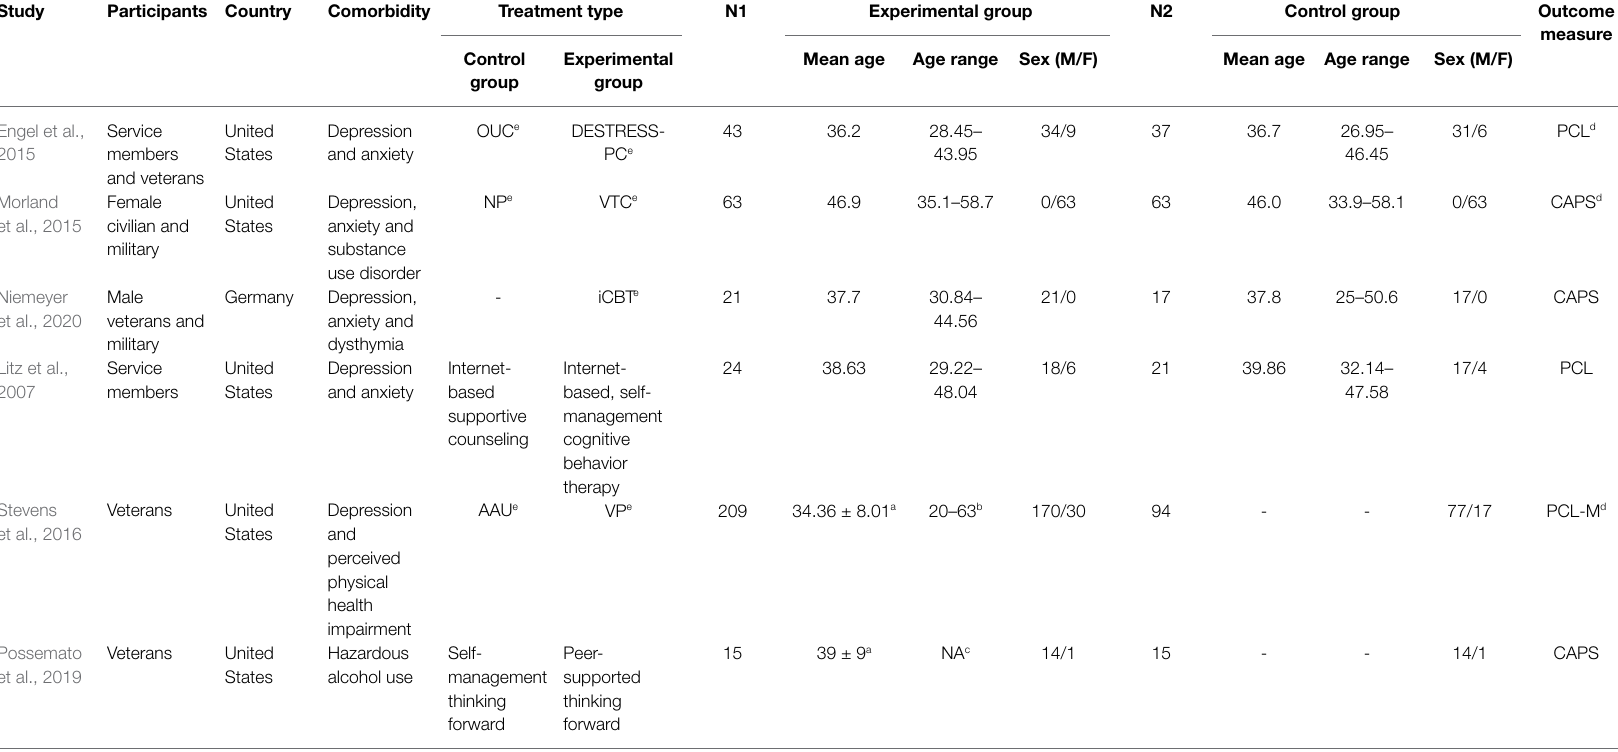
TABLE 1 | Key characteristics of participants and RCTs in the